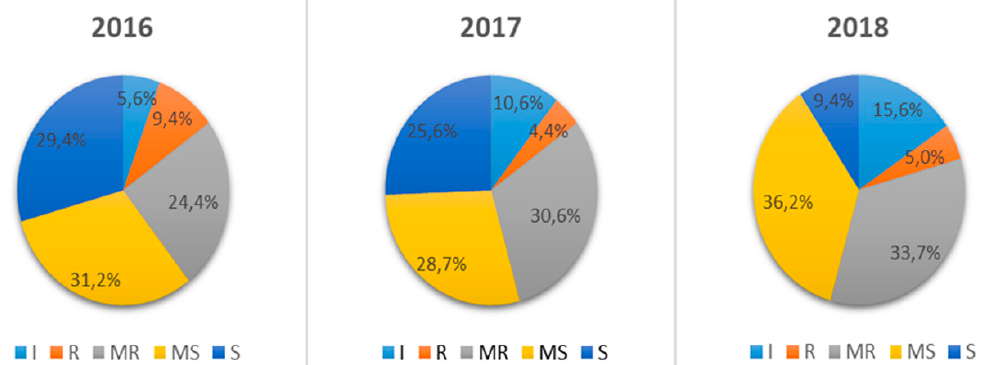
Figure 1. Diagram of distribution of spring wheat varieties by susceptibility to stem rust during 2016– 2018